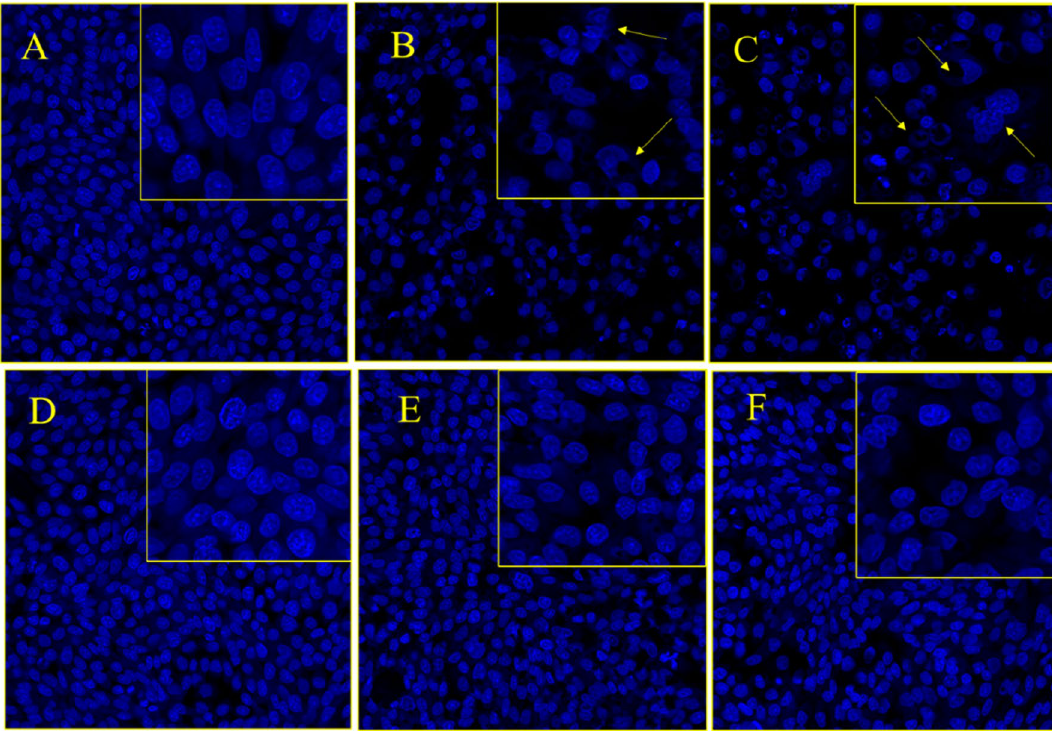
Figure 8. The impact of MNPs and MENCs treatment HCT-116 cells stained with DAPI after 48 h treatment. ( A , D ) are the control cell, ( B ) (CoFe 2 O 4 ), ( C ) (MnFe 2 O 4 ), ( E ) (CoFe2O4@BTO), and ( F ) (MnFe2O4@BTO). Arrows show the apoptosis